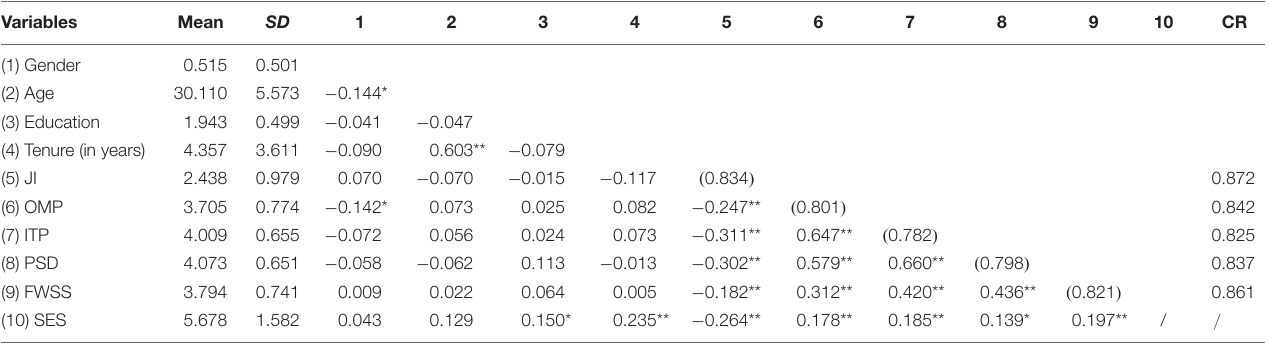
TABLE 1 | Correlations, means, SDs, AVEs, and CR among the variables.